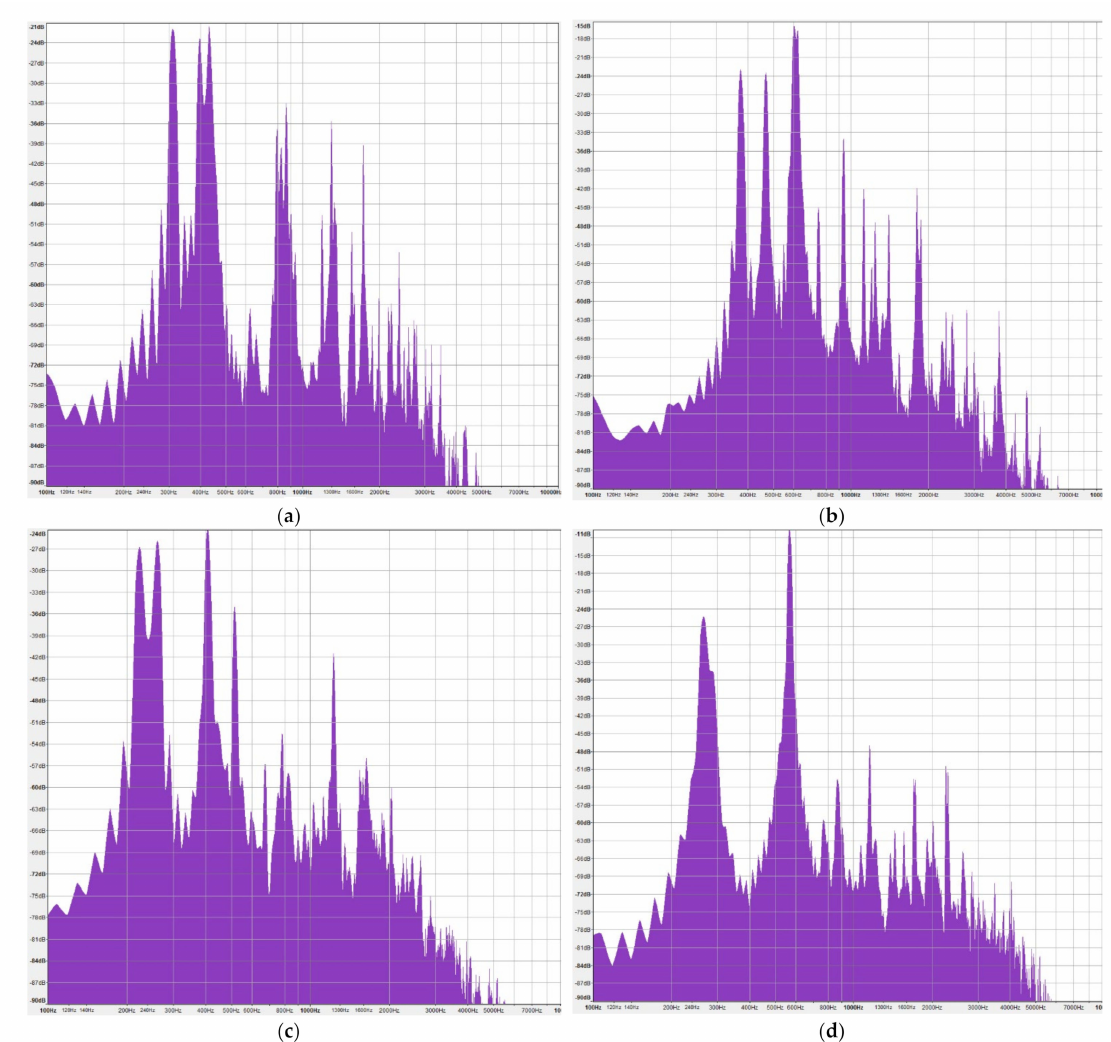
Figure 25. Spectra of quadruple flute experimental model from the “Zacuala Palace”, low blowing pressure: ( a ) all fingerholes stopped; ( b ) all fingerholes open; ( c ) fingerholes of pipes A–B open, pipes C–D stopped; ( d ) fingerholes of pipes A–B stopped, pipes C–D open (Sample